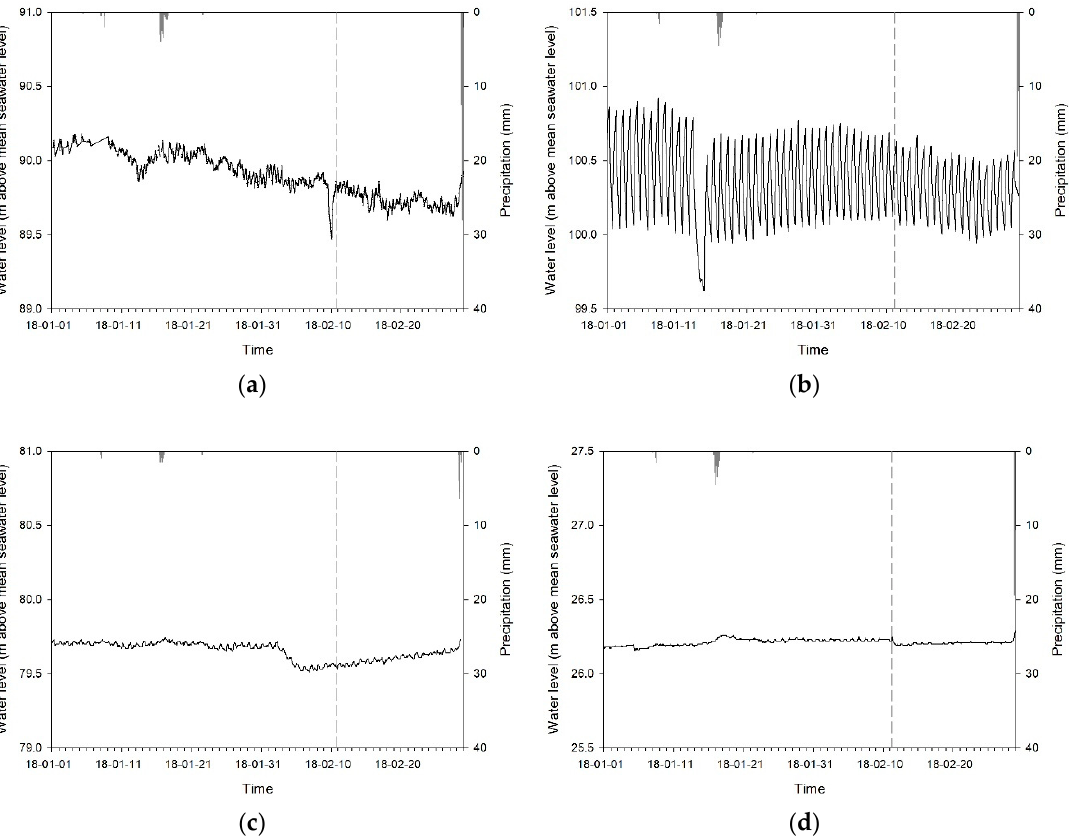
Figure 4. Groundwater fluctuations observed at ( a ) monitoring station MW1, ( b ) Pohang4 RGMN station, ( c ) Pohang5 RGMN station, and ( d ) Pohang-Jangheung NGMN station between January and February 2018. The vertical dashed line indicates the occurrence time of the M4.6 earthquake. The MW1, Pohang4, Pohang5, and Pohang-Jangheung stations were 88.9 km, 16.1 km, 11.9 km, and 11.9 km apart from the epicenter.